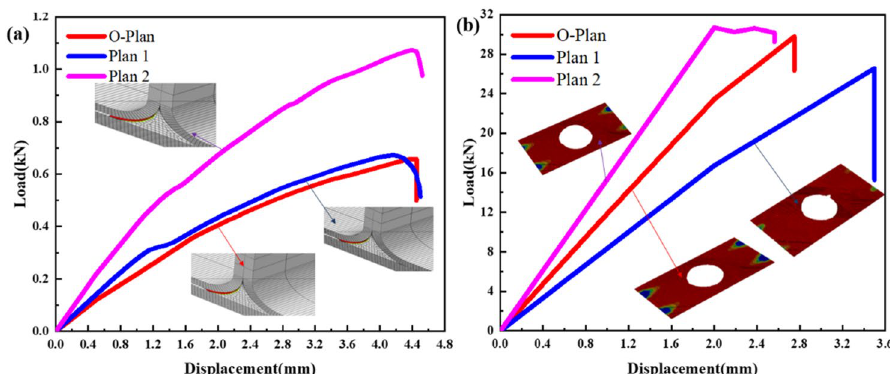
Figure 15. The simulation results: ( a ) comparison of finite element calculation results of various lateral bending plans; ( b ) comparison of finite element calculation results of various shearing plans (ABAQUS 6.14, https:// www. 3ds. com/ produ cts- servi ces/ simul ia/ produ cts/ abaqus) 43